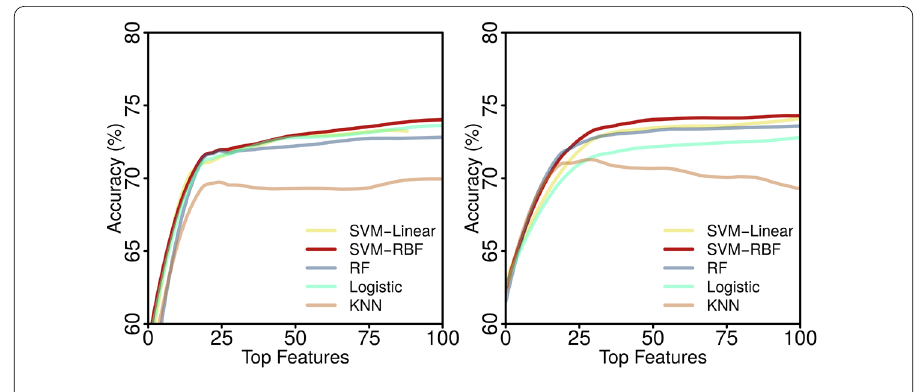
Figure 7 Accuracy as a function of the number of features in EU (left), SA (right) .